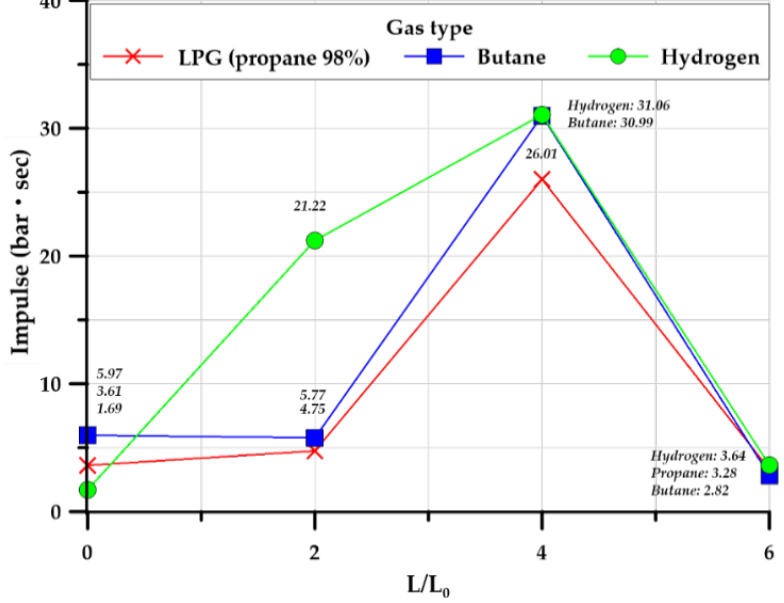
Figure 15. Average of impulse in the cylinder-type. These results demonstrated that hydrogen had shorter rising time and duration than those of hydrocarbon-based gases, and it exhibited a higher impulse because the maximum overpressure was higher than that of hydrocarbon-based gases. Therefore, an important aspect of hydrogen gas in designing structures is that it has a short rising time and duration but exerts an instantaneous impact on the structure because of a high explosive overpres- sure. Conversely, hydrocarbon-based combustible gases have long rising time and duration but sustained impact due to the relatively low explosion overpressure.